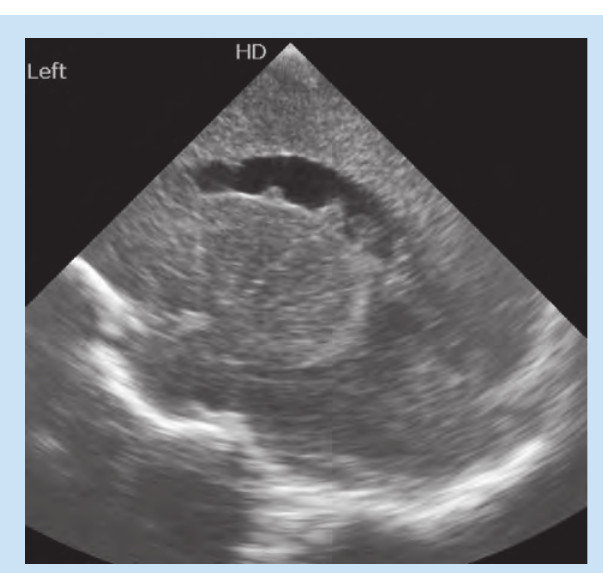
Fig. 3. Parasagittal US scan through the lateral aspect of the left lateral